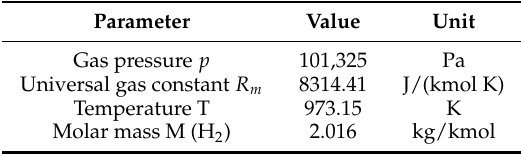
Table 2. Parameters and values used for the calculation of hydrogen density at 973 K [32].